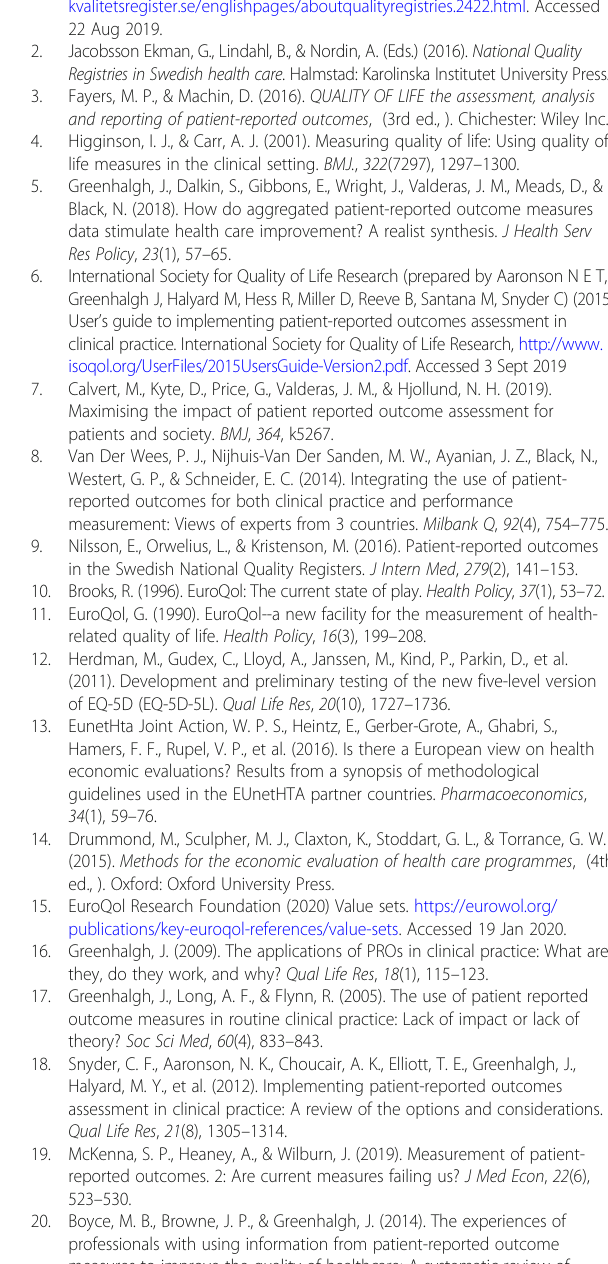
Additional file 1: Table S1. Template requesting information regarding the registries ’ collection, presentation, and use of EQ-5D (originally in Swedish). Table S2. Collection of EQ-5D. Registries within the category of Cancer. Table S3. Collection of EQ-5D. Registries within the category of Circulatory system. Table S4. Collection of EQ-5D. Registries within the category of Endocrine organs. Table S5. Collection of EQ-5D. Regis- tries within the category of Infection. Table S6. Collection of EQ-5D. Registries within the category of Musculoskeletal system. Table S7. Col- lection of EQ-5D. Registries within the category of Nervous system. Table S8. Collection of EQ-5D. Registries within the category of Paediatrics. Table S9. Collection of EQ-5D. Registries within the category of Psych- iatry. Table S10. Collection of EQ-5D. Registries within the category of Stomach and intestines. Table S11. Collection of EQ-5D. Registries within the category of Other areas (rare diseases). Table S12. Collection of EQ- 5D. Registries within the category of Other areas (skin